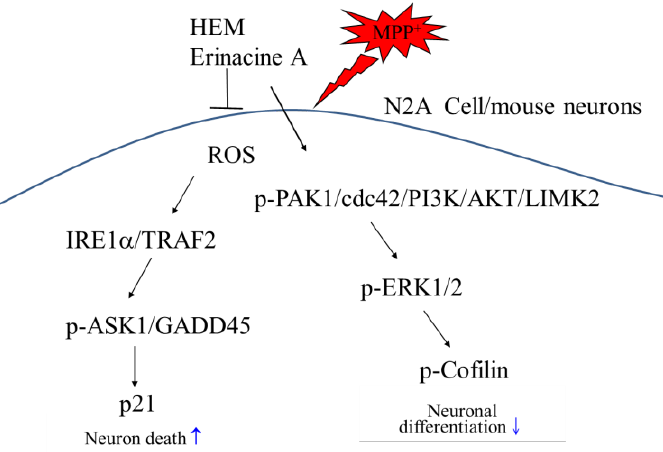
Figure 9. Schematic presentation of erinacine A prevention against MPP + -induced neurotoxicity via either induction of the p-PAK1 / cdc42 / PI3K / AKT / LIMK2 cell survival pathways or the reduction of the IRE1 α / TRAF2 / ASK1 / GADD45 / p21 cell death pathway. In addition to decreasing the cell death pathways (IRE1 α / TRAF2, ASK1, GADD45, and p21), our findings revealed a new paradigm for protect neurons against MPP +